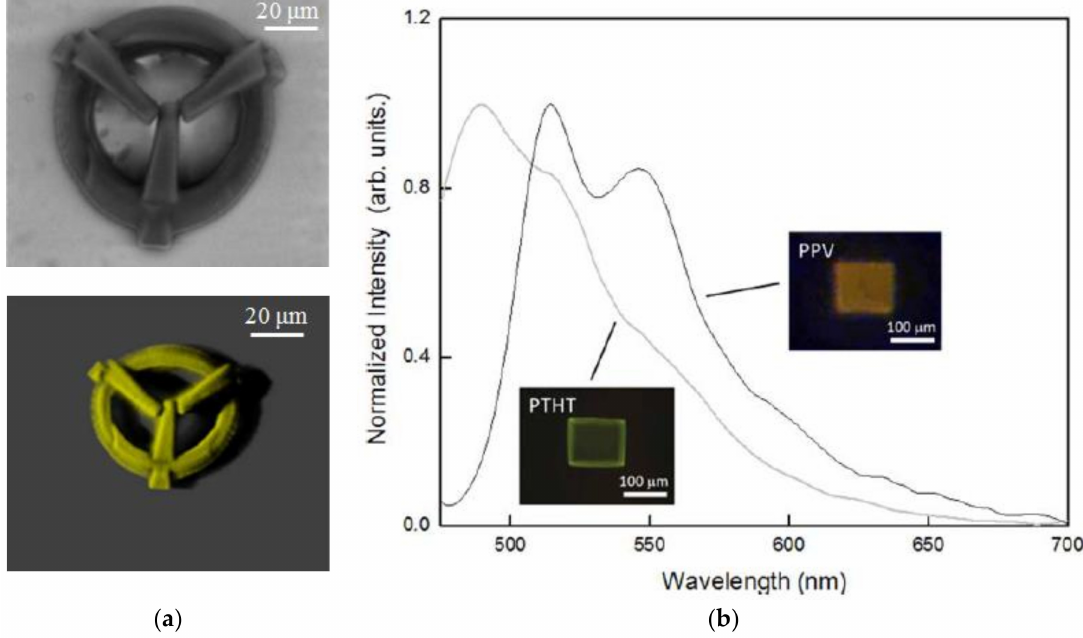
Figure 26. ( a ) The SEM and fluorescence images of PPV-doped microstructure; and ( b ) photoluminescence spectra of the same direct writing structure before (PTHT doped) and after thermal conversion (PPV doped)